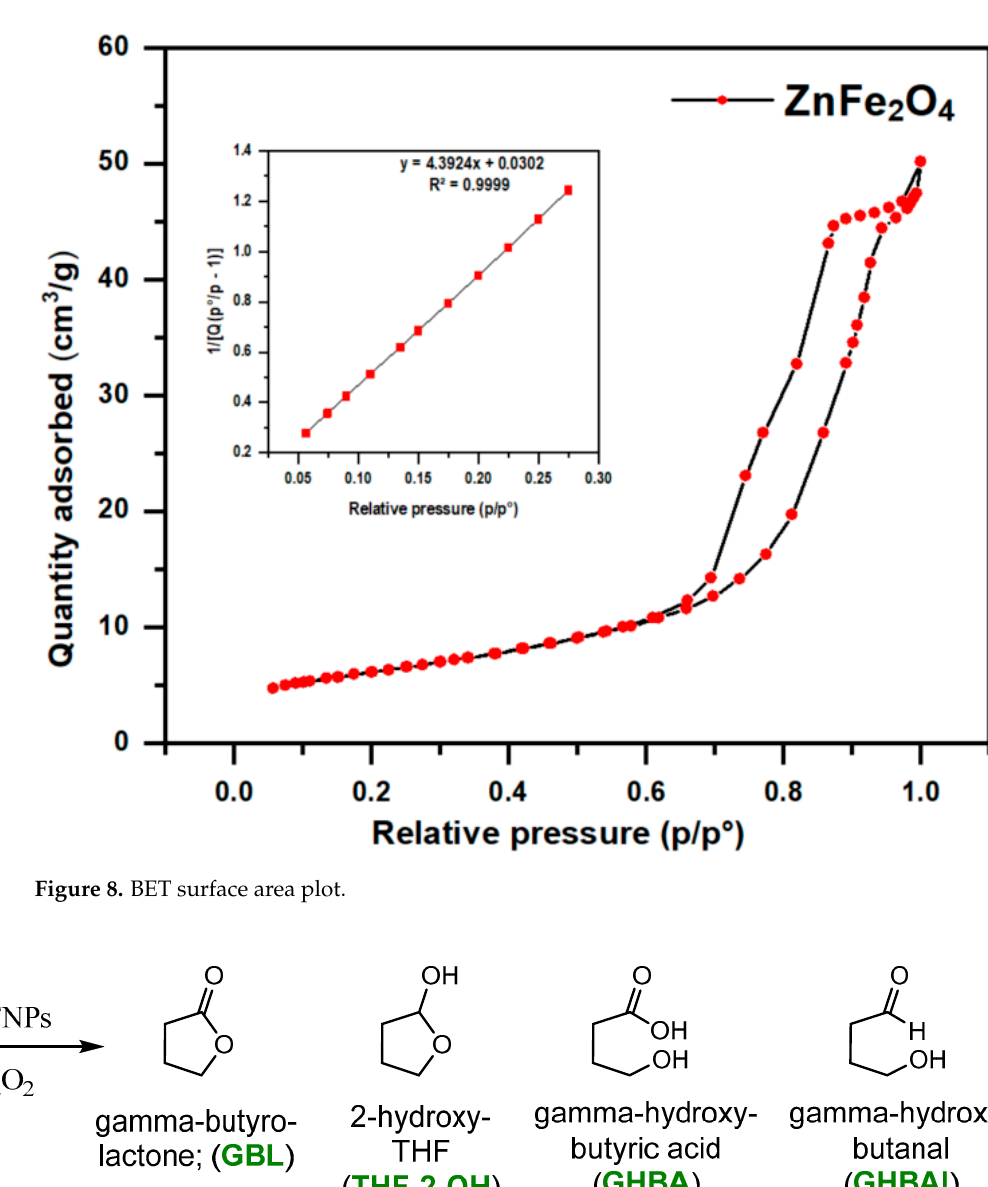
Figure 8. BET surface area plot.